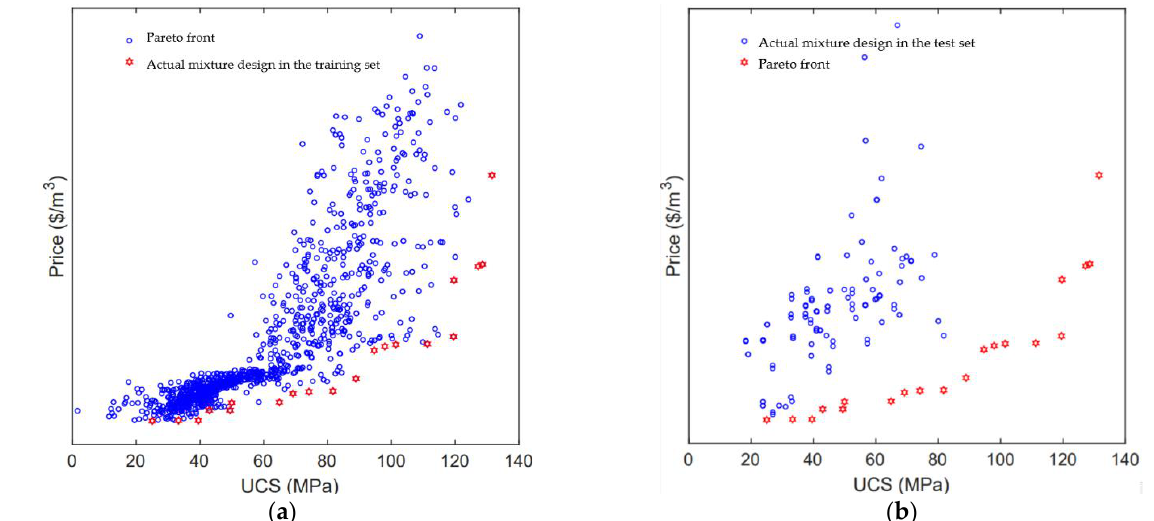
Figure 9. Pareto front of the concrete mixtures. ( a ) Training set; ( b ) Test set. Since the UCS and cost of concrete are two conflicting goals, with the increase in cement content in concrete, the UCS of concrete also increases. However, due to the relatively high cost of cement, the cost of concrete also increases. To find the best mixture ratio for the optimization of the UCS and cost of concrete, this paper uses TOPSIS to rank the scores of twenty Pareto front optimal solutions. The TOPSIS scores of each point of Pareto front optimal solutions are shown in Table 4. It can be seen that the score of the Pareto front optimal solution with the highest score is 1. At this time, the UCS of the corresponding concrete is 119.48 MPa and the cost is 37.29 USD/m 3 . The contents of cement, water, blast furnace slag, coarse aggregate, fine aggregate and superplasticizer in the optimal concrete mixture are 484.21, 191.44 kg/m 3 , 239.70, 1080.26 kg/m 3 , 983.94 kg/m 3 , and 3.72 kg/m 3 , respectively. Table 4. Concrete mixtures by TOPSIS score.